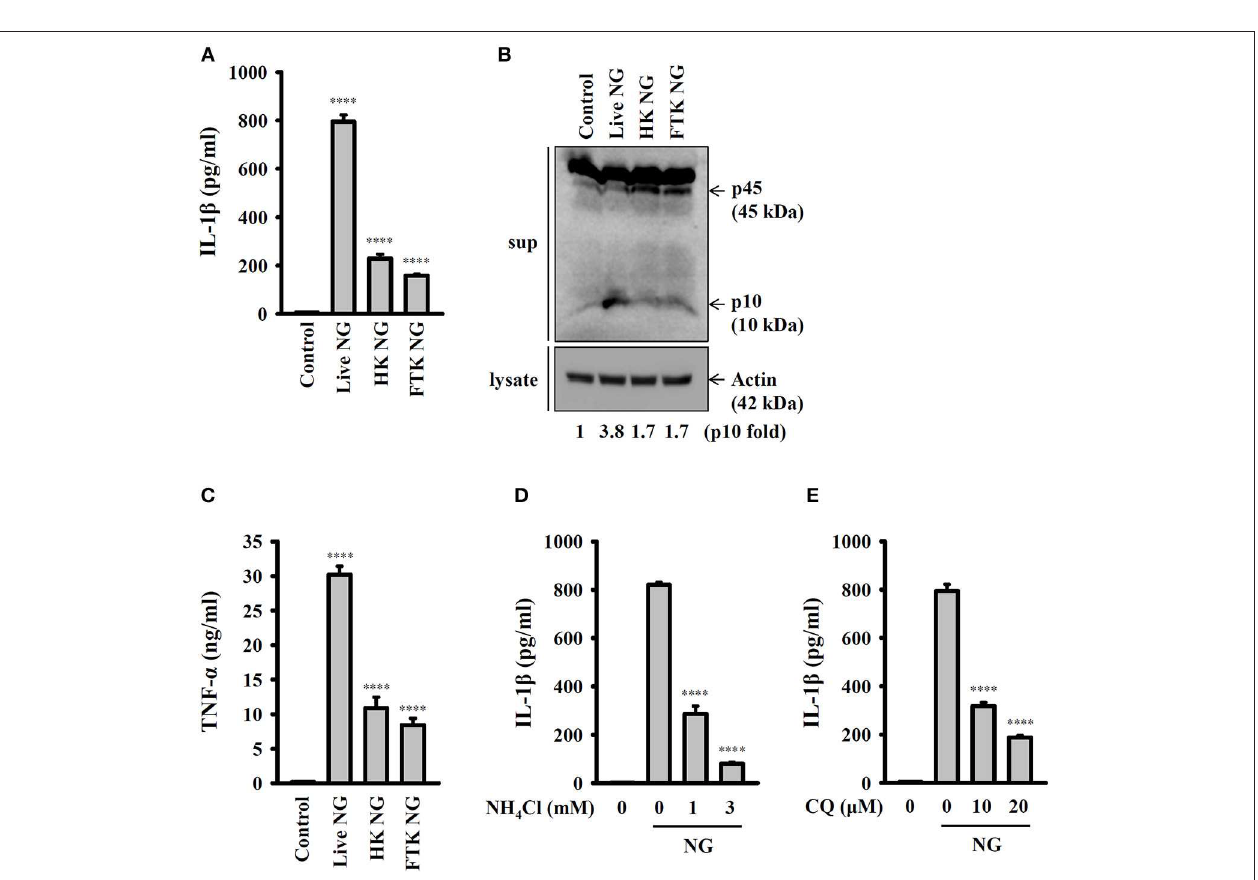
FIGURE 1 | supernatants were measured by Western blotting analysis. (F) THP-1 monocytes, THP-1 macrophages and PBMCs were infected for 24h with NG. The levels of IL-1 β in the supernatants were measured by ELISA. (G) J774A.1 macrophages were incubated for 0.5h with MCC950 followed by infected for 24h with NG. The levels of IL-1 β and p45/p10 in the supernatants were measured by ELISA and Western blotting analysis, respectively. (H) Wild-type and NLRP3-knockout (NLRP3-KO) J774A.1 macrophages were incubated for 5h with LPS (1 µ g/ml). The protein expression levels of NLRP3 were measured by Western blotting. (I) Wild-type or NLRP3-KO J774A.1 macrophages were infected for 24h with NG. The levels of IL-1 β and p45/p10 in the supernatants were measured by ELISA and Western blotting analysis, respectively. The ELISA data are expressed as the mean ± SD of three separate experiments. The Western blotting results are representative of three different experiments, and the band intensity was analyzed by ImageJ and expressed as the fold change compared with the control group normalized to actin. A significant difference at the level of **** p < 0.0001 compared to untreated control cells (A,C,F) , NG-infected cells (G) or as indicated (I) . [One-way ANOVA with Dunnett’s multiple comparisons test in (A,C,F,G) ; two-tailed t- test in (I) ].